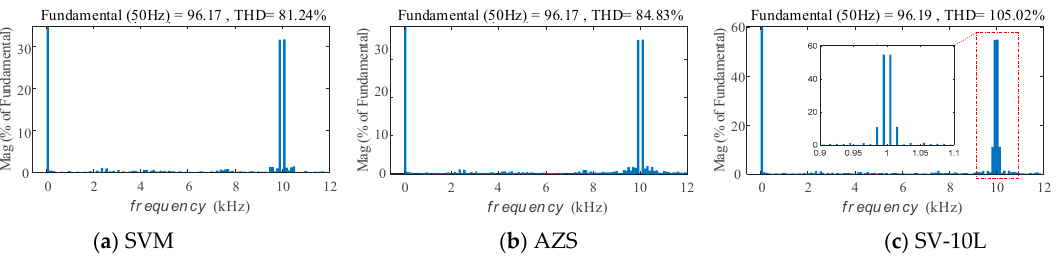
Figure 8. FFT analysis for the output phase voltage of the conventional SVM and proposed CMVR schemes.